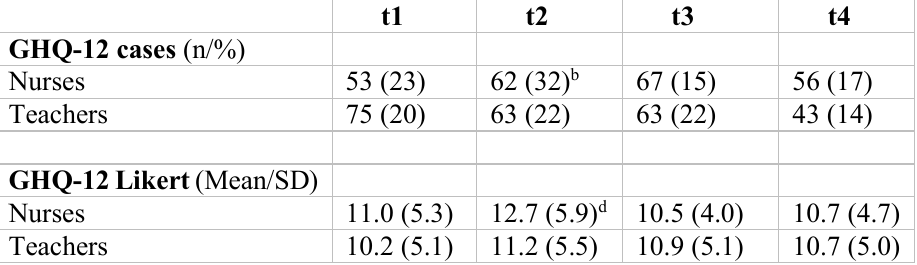
Cross-sectional and longitudinal descriptive data about psychological distress at each of the four time